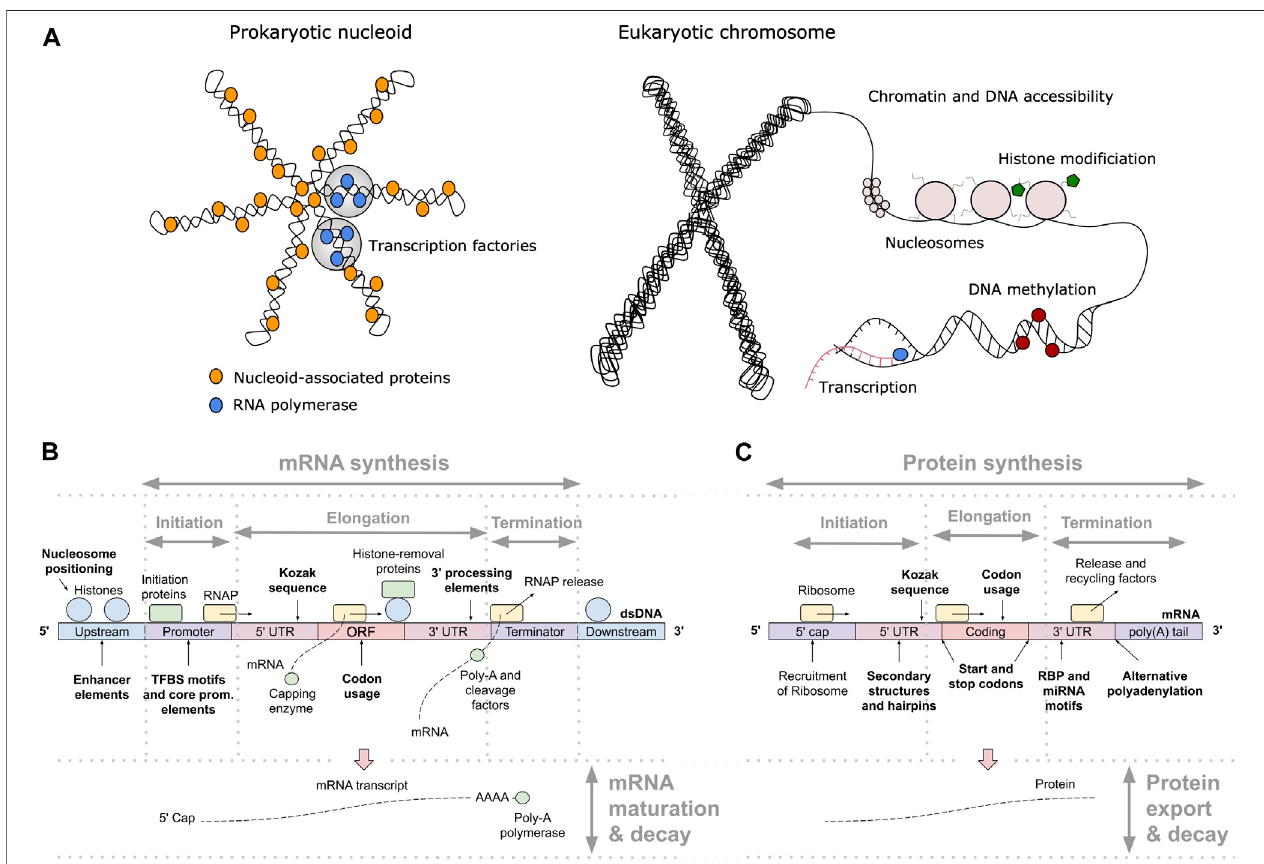
FIGURE 1 | Principles of gene expression. (A) Protein-DNA interactions in prokaryotic nucleoid and eukaryotic chromosome structure, epigenetics and transcription initiation. The basic repeating structural unit of chromatin is the nucleosome, which contains eight histone proteins. Bacterial nucleoid-associated proteins are the main regulators of nucleoid structure, where the circular genome is supercoiled and uncoiled by these proteins. In cells, genes are switched on and off based on the need for product in response to cellular and environmental signals. This is regulated predominantly at the level of transcription initiation, where chromatin and nucleoid structure open and close, controlling the accessibility of DNA and de fi ning areas with high amounts of transcription (factories) upon demand. (B) Depiction of eukaryotic transcription across the gene regulatory structure that includes coding and non-coding regulatory regions. The open reading frame (ORF) carries the coding sequence, constructed in the process of splicing by joining introns and removing exons. Each region carries speci fi c regulatory signals, including transcription factor binding sites (TFBS) in enhancers, core promoter elements in promoters, Kozak sequence in 5 ′ untranslated regions (UTRs), codon usage bias of coding regions and multiple termination signals in 3 ′ UTRs and terminators, which are common predictive features in ML (highlighted bold). RNAP denotes RNA polymerase, mRNA messenger RNA. (C) Depiction of eukaryotic translation across the mRNA regulatory structure, where initiation involves the 5 ′ cap, Kozak sequence and secondary structures in the 5 ′ UTR. Codon usage bias affects elongation, whereas RNA-binding protein (RBP) sites, microRNA (miRNA) response elements and alternative polyadenylation in the 3 ′ UTR affect post-translational processing and fi nal expression levels. These regulatory elements are common predictive features in ML (highlighted